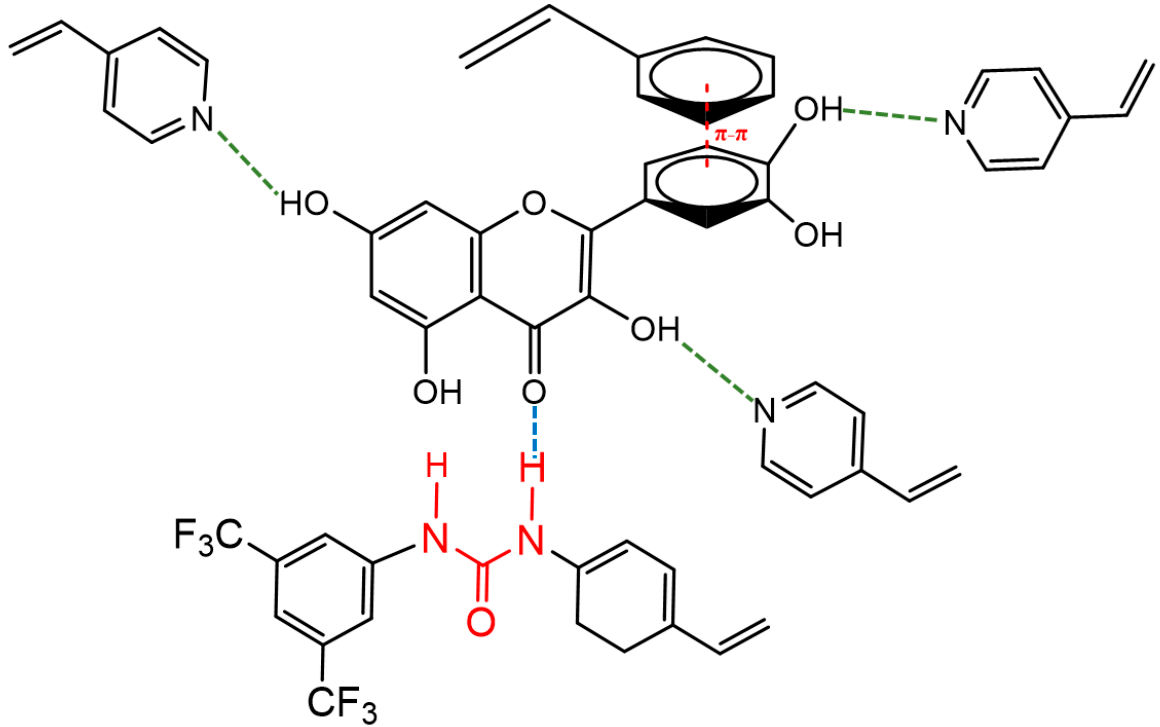
Figure 1. Predicted interactions between quercetin and FMs.